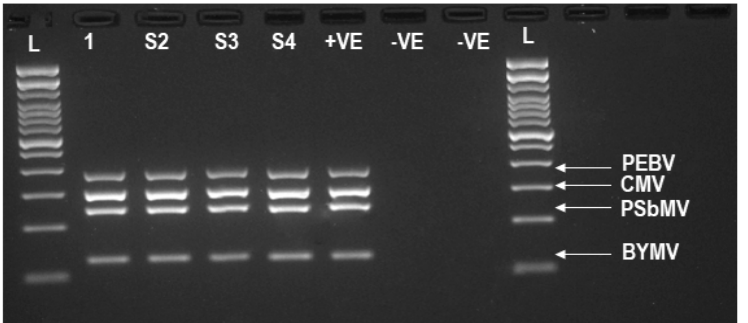
Figure 1. Agarose gel electrophoresis from an mPCR of the four viruses (BYMV, PSbMV, CMV and PEBV) quadruplicate (×4) samples. The (+VE) positive control infected viral RNA pooled together from (BYMV, PSbMV, CMV and PEBV) infected samples amplified using HcPro-1F/HcPro-1FR,PCP-F1/PCP-F1R,CMVRNA1F/CMVRNA1R,201K-F/201K-R primers. The (-VE) negative controls were RNase/DNase-free water and a viral-negative sample (healthy oat plant). L = Invitrogen ready to use 1 kb Plus DNA ladder used on both right and left side of the gel.